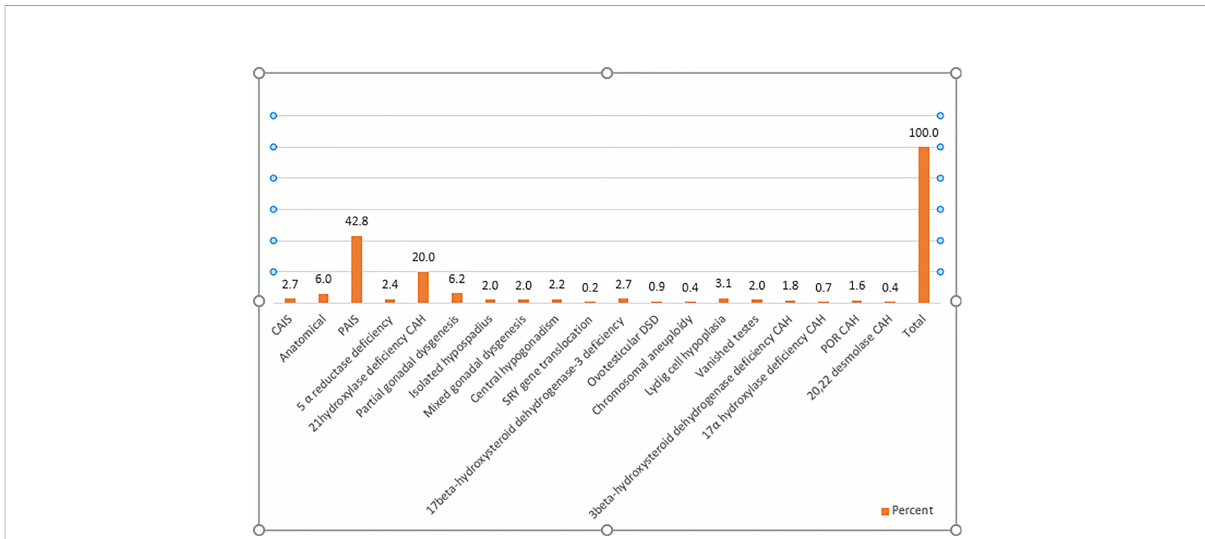
FIGURE 1 Etiological classi fi cation of cases of DSD. CAH, congenital adrenal hyperplasia; CAIS, complete androgen insensitivity; DSD, differences of sex development; PAIS, partial androgen insensitivity; POR CAH, P450 oxidoreductase de fi